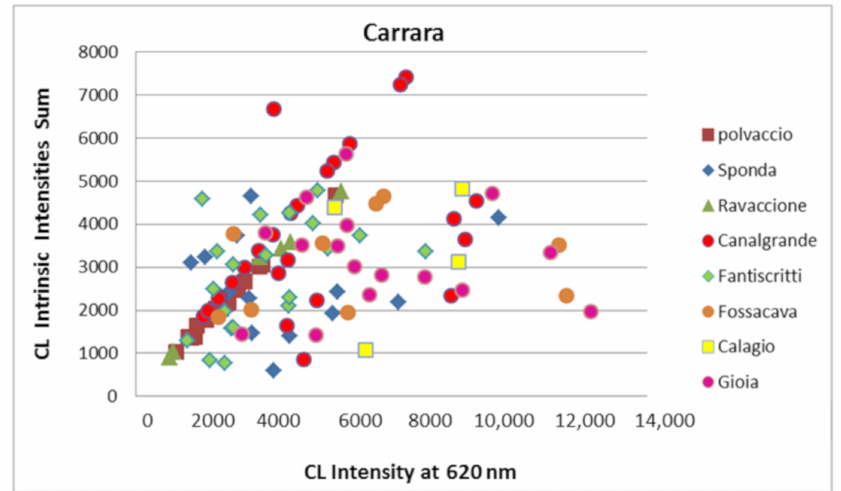
Figure 3. Quantitative CL diagram for Carrara marble from di ff erent quarries located in three valleys (Torano, Miseglia, and Colonnata, according to